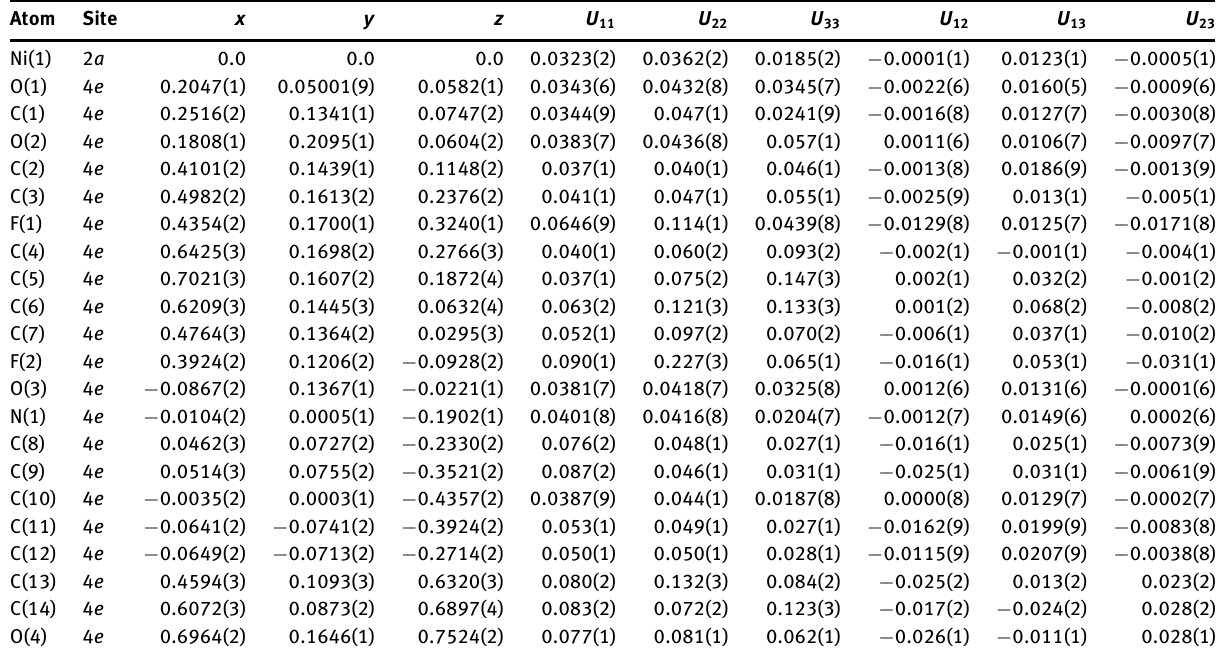
Table 3: Atomic displacement parameters (Å 2